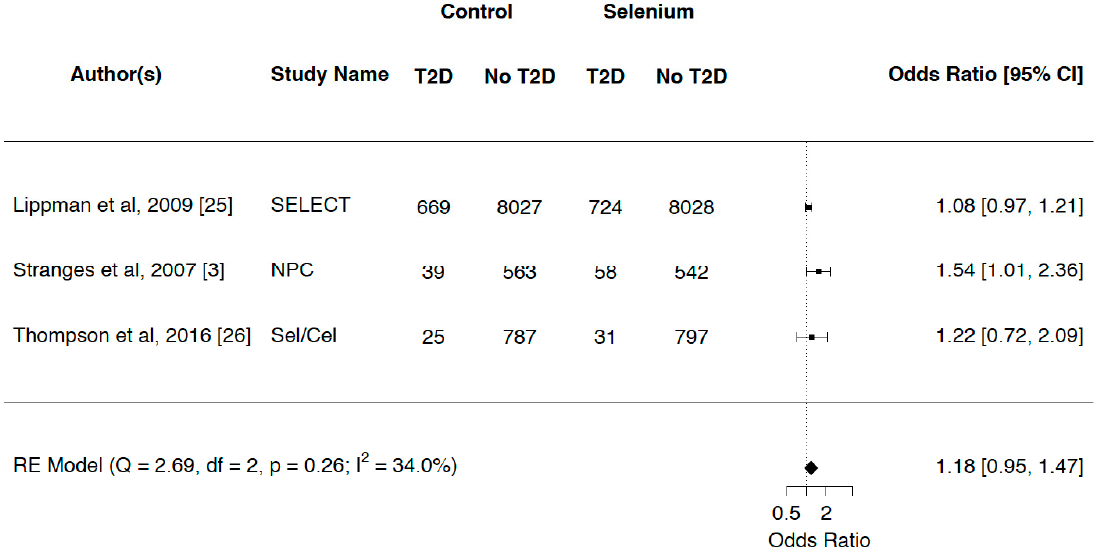
Figure 3. Odds ratios (95% CIs) and summary statistics for randomized clinical trials (RCTs).